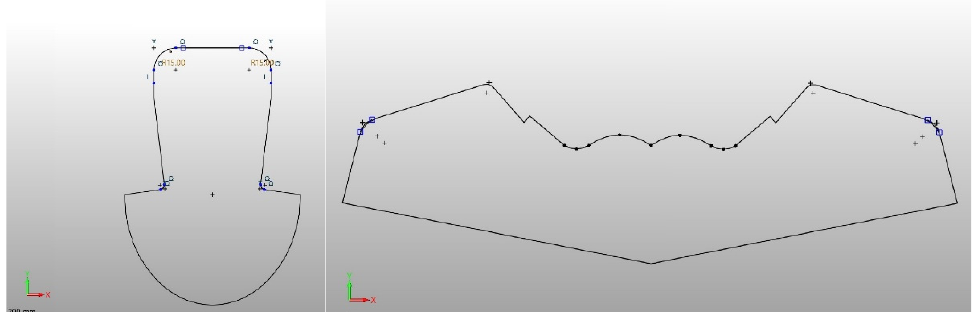
Figure 12. The template shapes of the footwear elements designed in the ZW3D CAD program.